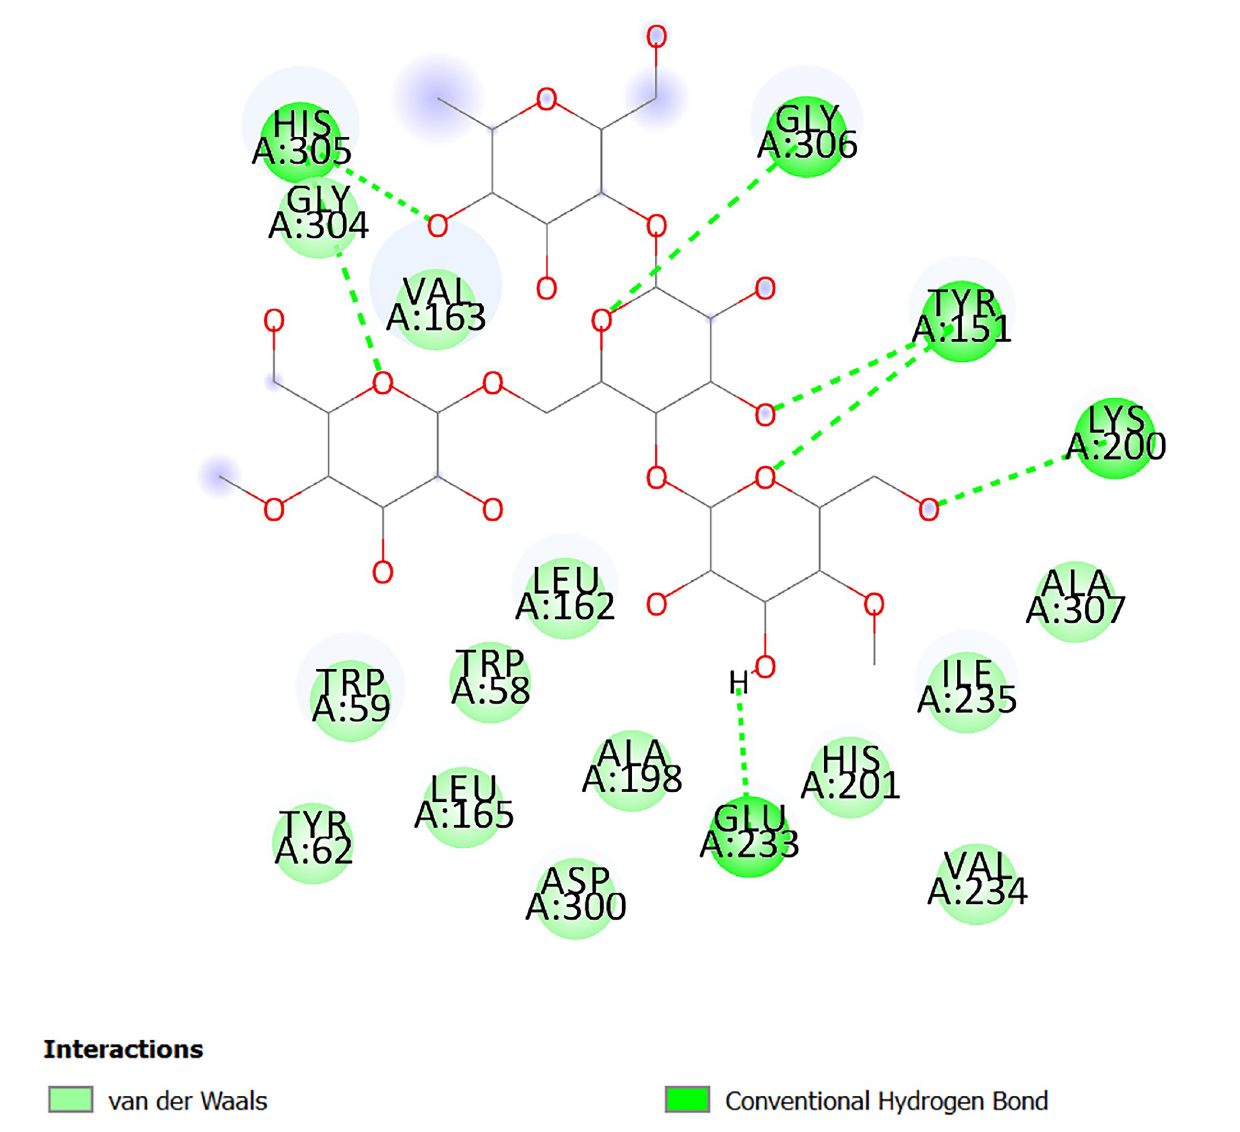
Fig 3. 2D diagram of interactions between corn starch and 1OSE.